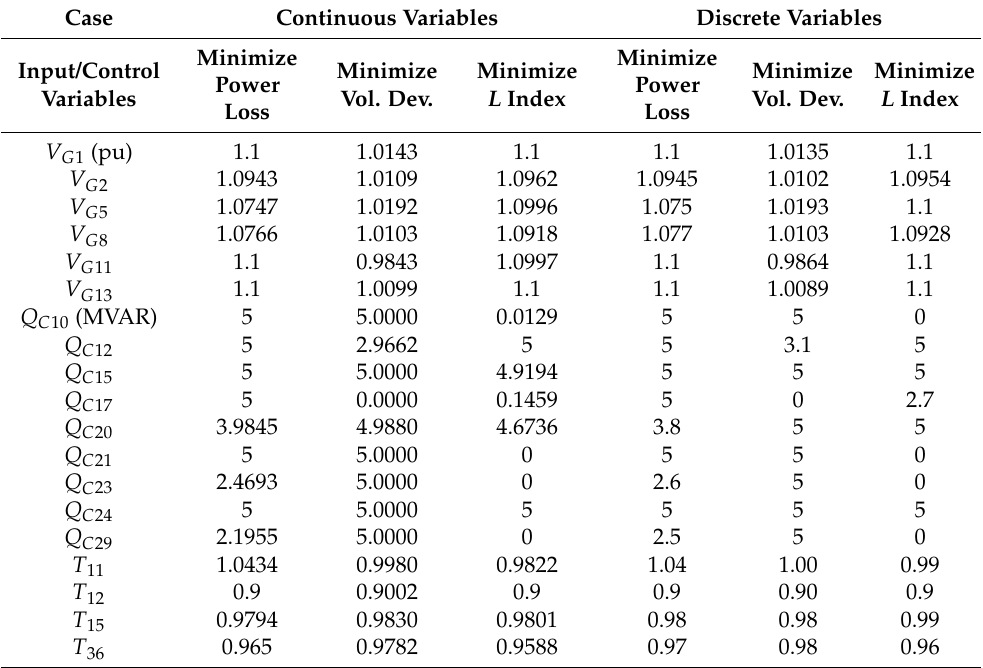
Table A1. Optimal solutions obtained by ICOA for the IEEE 30-bus